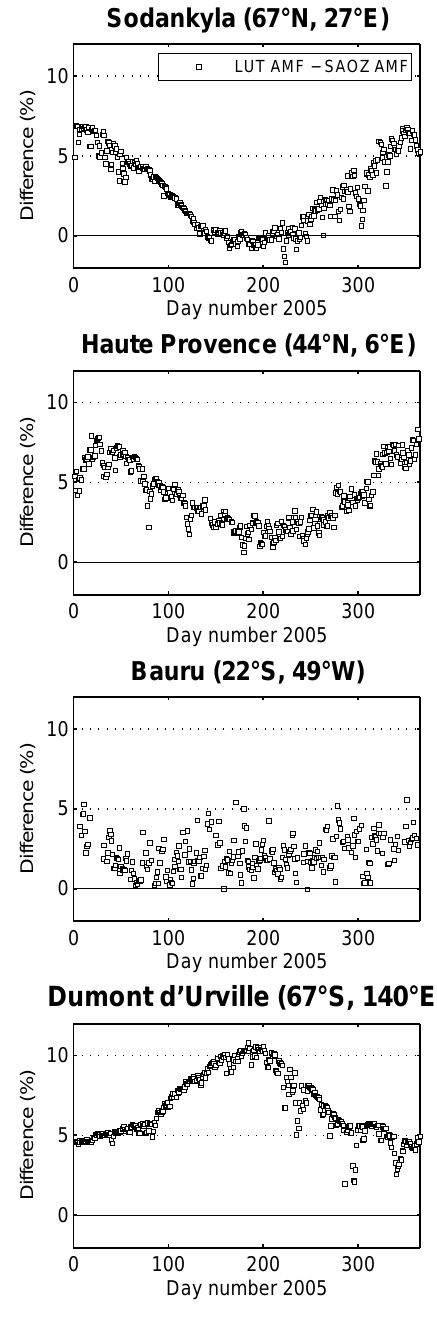
Fig. 3. Relative differences between LUT and SAOZ O 3 AMFs at 90 ◦ SZA for the year 2005 at Sodankyla (67 ◦ N, 27 ◦ E), Haute Provence (44 ◦ N, 6 ◦ E), Bauru (22 ◦ S, 49 ◦ W), and Du- mont d’Urville (67 ◦ S, 140 ◦ E). The SAOZ tropical, high- and mid- latitude O 3 AMF values at 90 ◦ SZA are 16.20, 16.22, and 16.52,